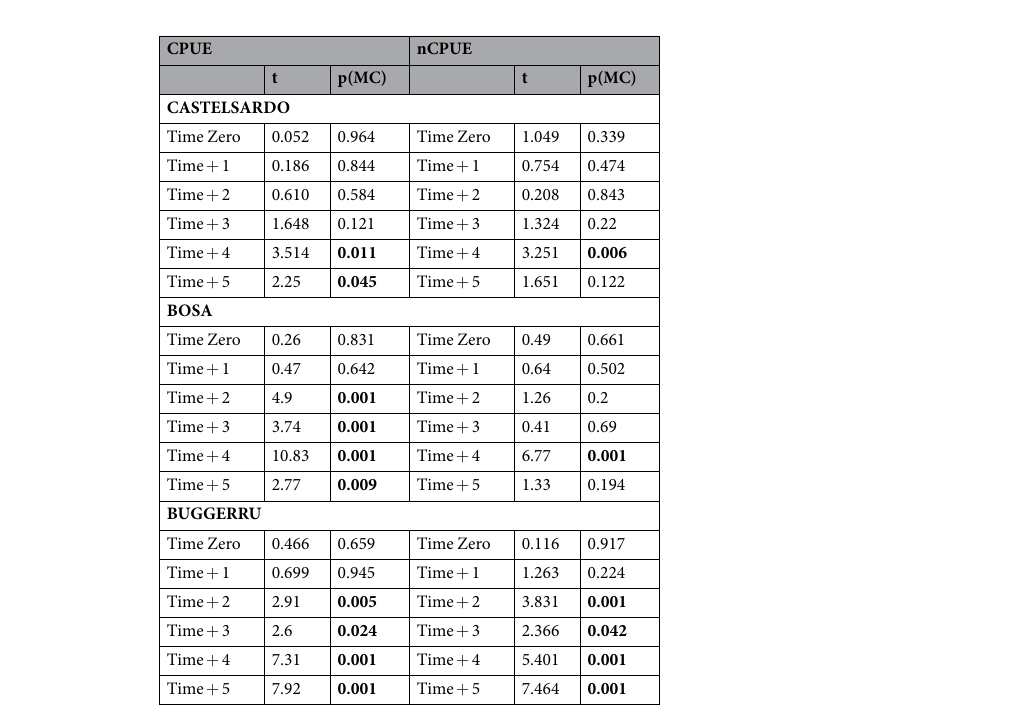
Table 3. Output from the pairwise comparison testing for differences in average CPUE among years in the inside (IN) and outside (OUT) portion of FPAs. Significant Monte Carlo p-values (pMC < 0.05) differences are reported in bold.